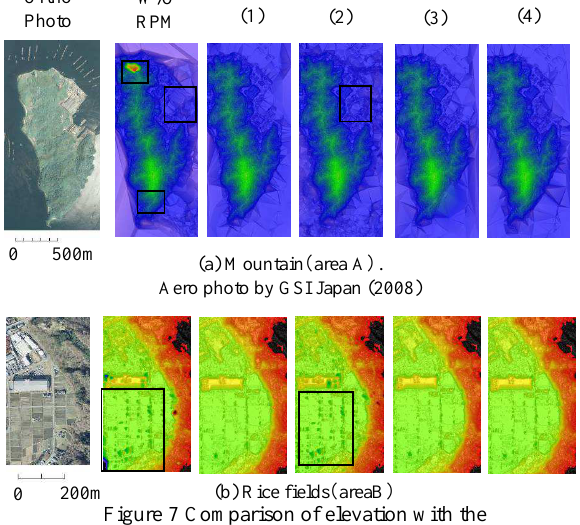
Figure 7 Comparison of elevation with